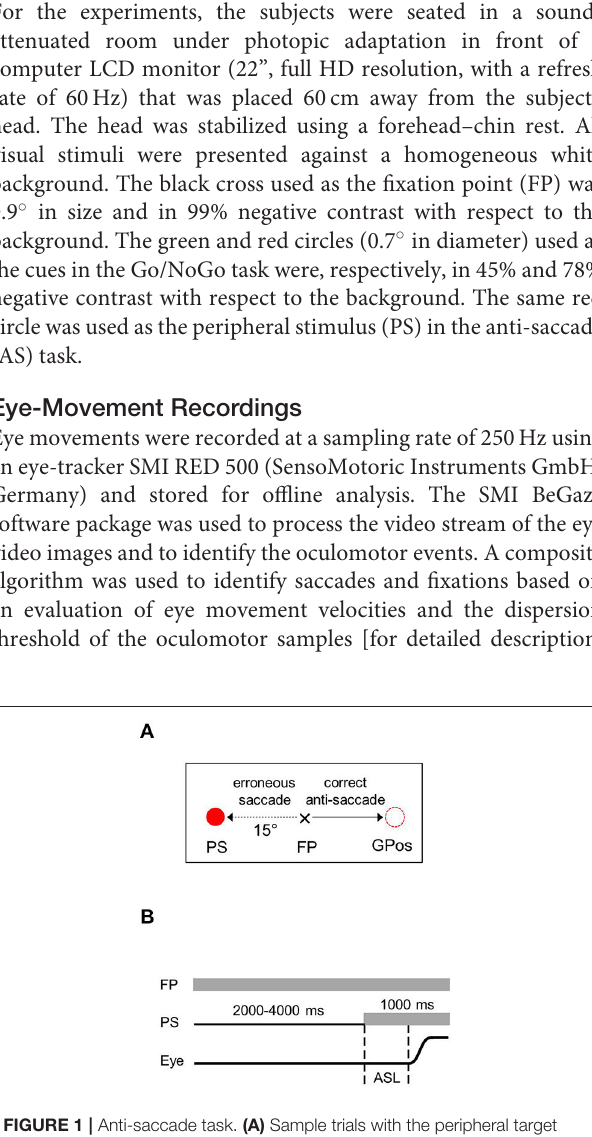
FIGURE 1 | Anti-saccade task. (A) Sample trials with the peripheral target occurring to the right of fixation point. (B) Time sequences of stimulation and events. FP, fixation point; PS, peripheral stimulus; Eye, schematic eye shift (a saccade); ASL, anti-saccade latency; GPos, gaze